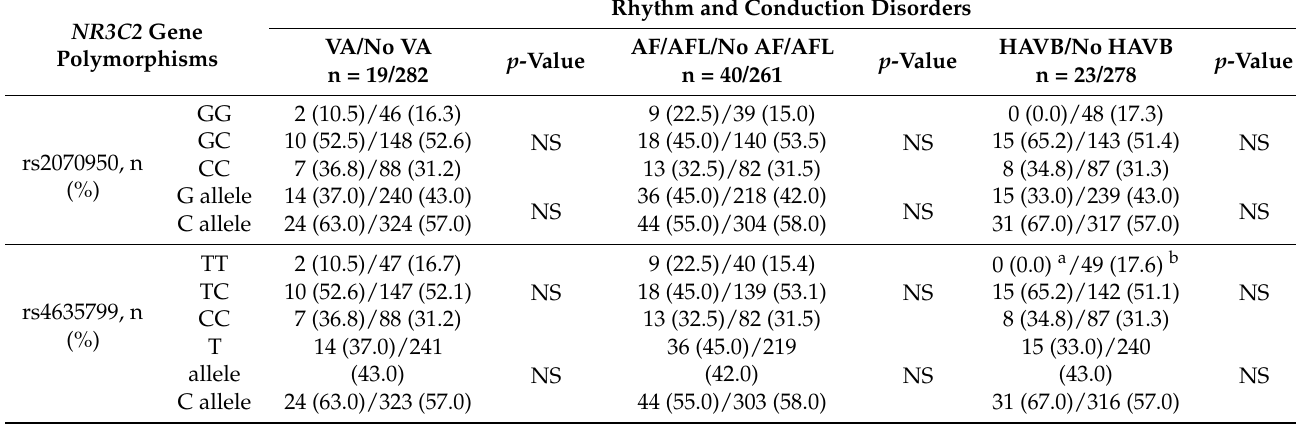
Table 4. NR3C2 Gene polymorphisms (n = 301) and their association with rhythm and conduction